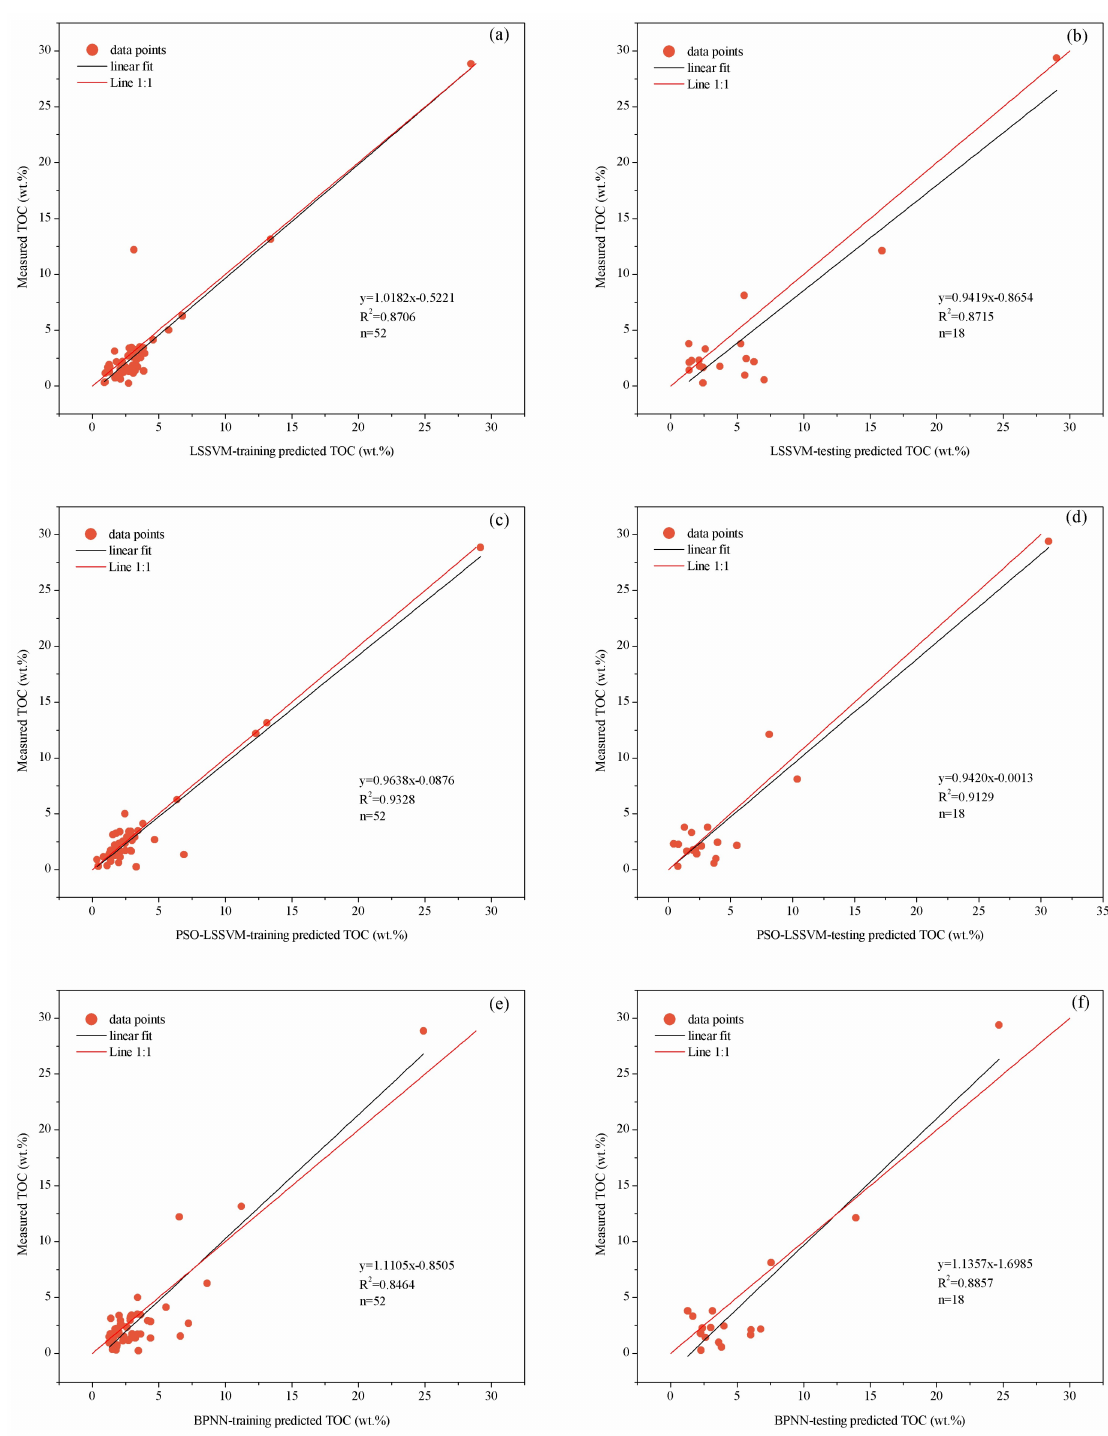
Figure 7. Comparison of the TOC prediction results with the original samples data and laboratory measured TOC: ( a ) LSSVM-training results; ( b ) LSSVM-testing results; ( c ) PSO-LSSVM-training results; ( d ) PSO-LSSVM-testing results; ( e ) BPNN-training results; and ( f ) BPNN-testing